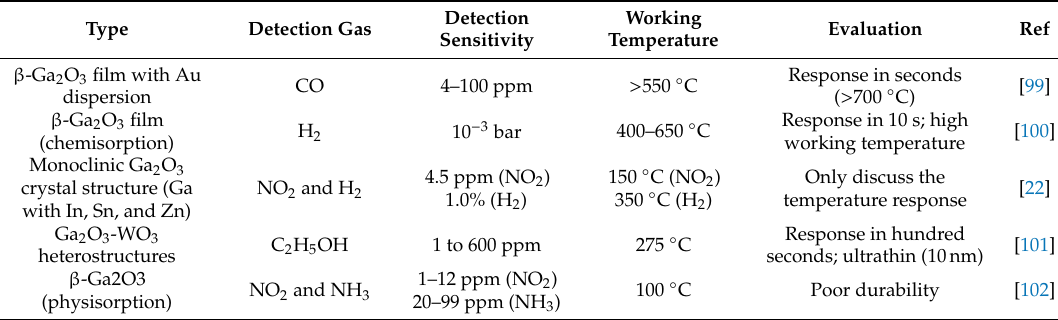
Table 2. Summary of gas sensor based on liquid